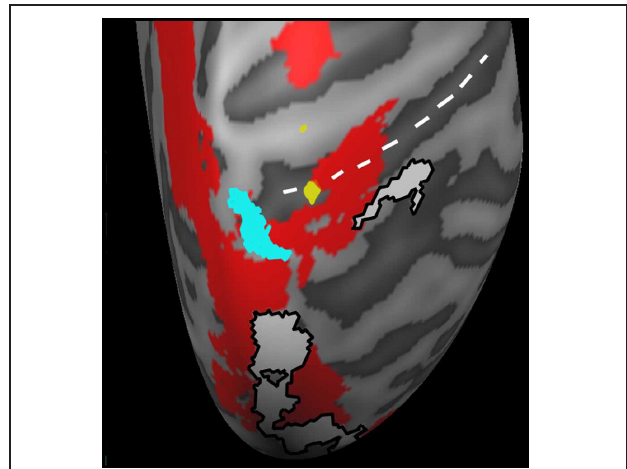
FIGURE 4 | A magnified dorsal view of the right hemisphere activation correlated with mean aJrk values during SteerPv trials (yellow; p < 0 . 001 unc.) and during SteerNr trials (turquoise; p < 0 . 001 unc.). Activations are shown in relation to SteerPv > HeadingPv (red: FDR, p < 0 . 05) and activity during the Sacc > Fix contrast (White: p < 0 . 001 unc.) from the PEF localizer. The white dotted line indicates the postcentral sulcus.